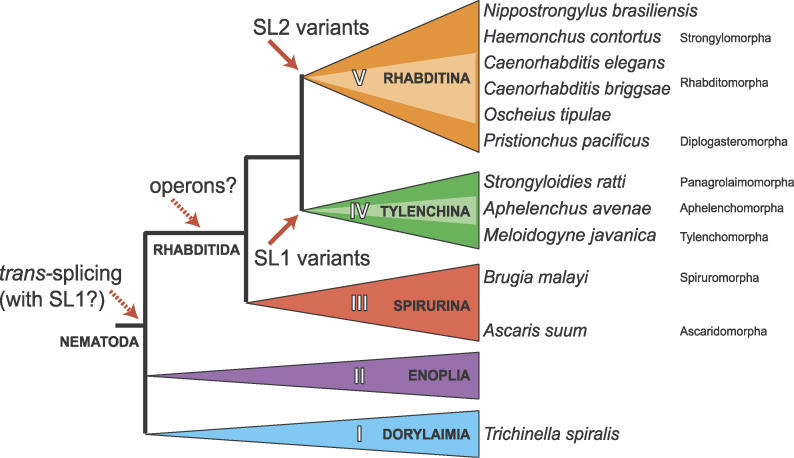
The Evolution of Operons and SL Usage through the Phylum NematodaOperons and SL usage in trans-splicing have been mapped onto a phylogeny of the Nematoda illustrating the relationships of the nematodes studied based on analysis of the small subunit rRNA (adapted from [37,38]). Conserved operons have been identified in Rhabditina, Tylenchina, and Spriurina (clades V, IV, and III of [37]). While SL1 may be a synapomorphy for the phylum, SL2-like SLs are apparently restricted to the Rhabditina, as is their use in trans-splicing to downstream genes in operons. An independent radiation of SL1-like SLs is used for downstream gene trans-splicing in the Tylenchina, while the Spirurina use canonical SL1.